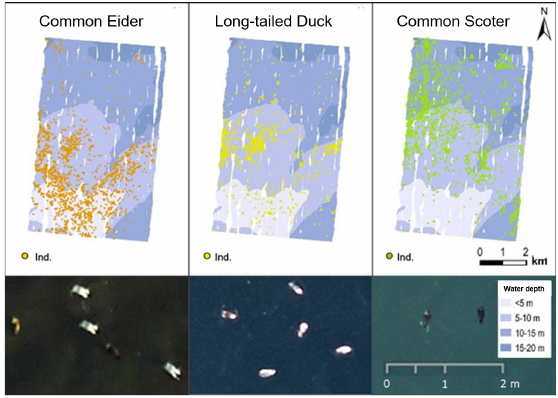
Figure 5. The distributions of three sea duck species based on gapless aerial photos taken on March 12 2014 in the German Baltic Sea (Bay of Wismar) in relation to different water depth classes. Maps are based on data by Steffen